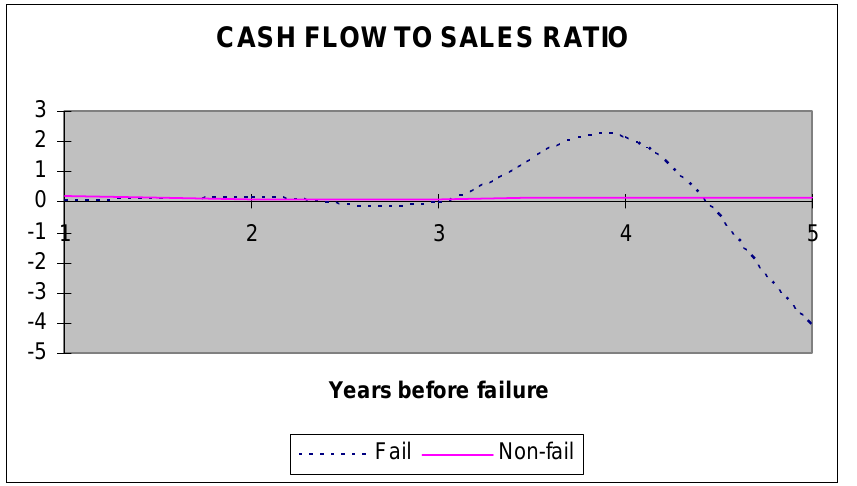
Figure 1: Cash flow to sales ratio CASH FLOW TO SALES